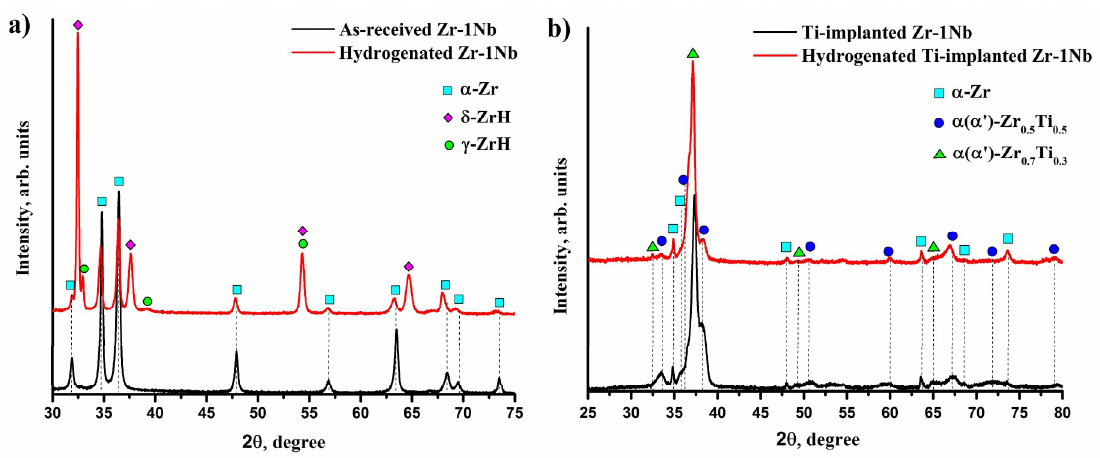
Figure 5. XRD patterns of ( a ) hydrogenated Zr-1Nb and ( b ) Ti-implanted Zr-1Nb alloy.